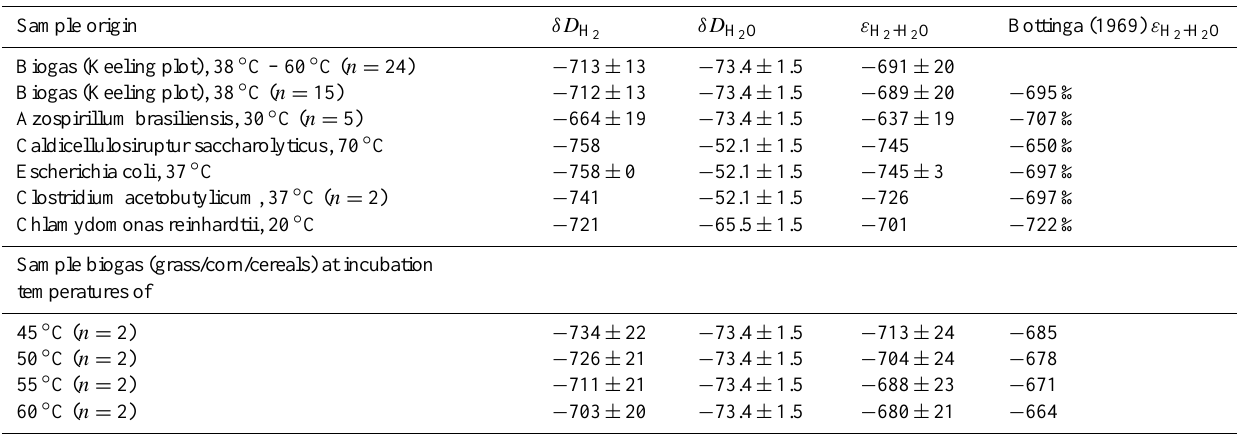
) , isotopic composition of the water used in the incubation ( δD H 2 . The δD H values for the biogas samples are taken from the keeling plot, values of 2 2 -H 2 O